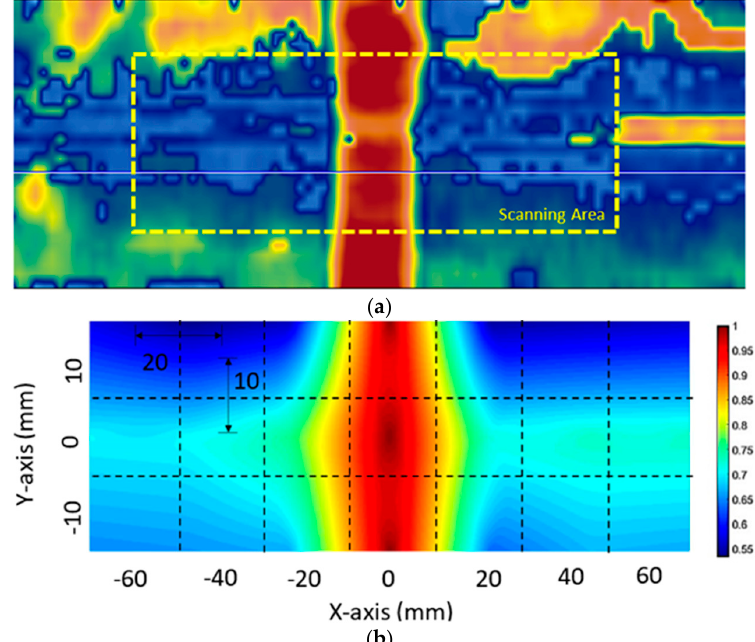
Figure 9. Visualization of the adhesive bonded aluminum plate 1: ( a ) C-Scan result and ( b ) results obtained using the proposed imaging algorithm.